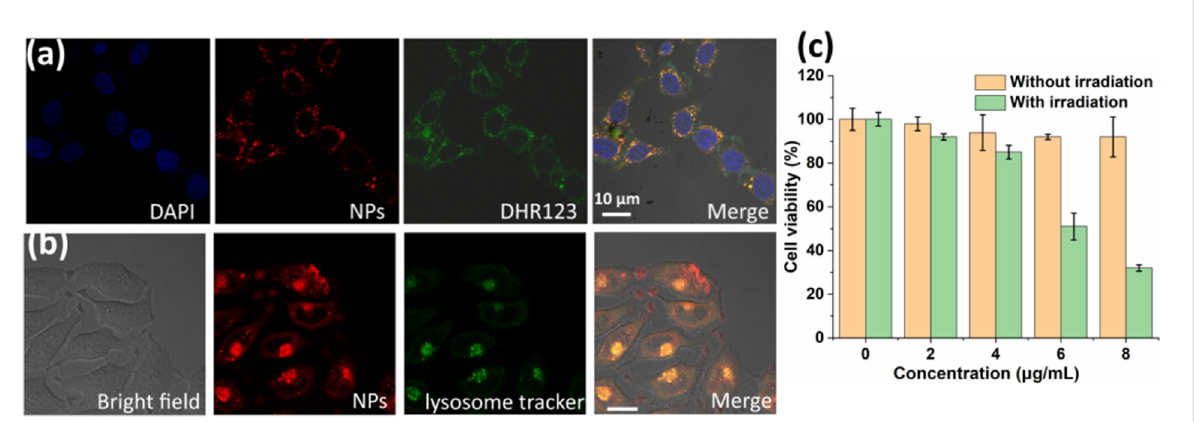
FIGURE 3 (A) In vitro cellular uptake and superoxide radical generation with DHR123 as a probe (730 nm, 100 W/cm 2 ). (B) Lysosome co-localization with PDPP NPs. (C) Cell viability of HeLa cells in the presence of PDPP NPs at different concentrations (0, 2, 4, 6, and 8 μ g/ml) (730 nm, 500 W/cm 2 , 8 min).